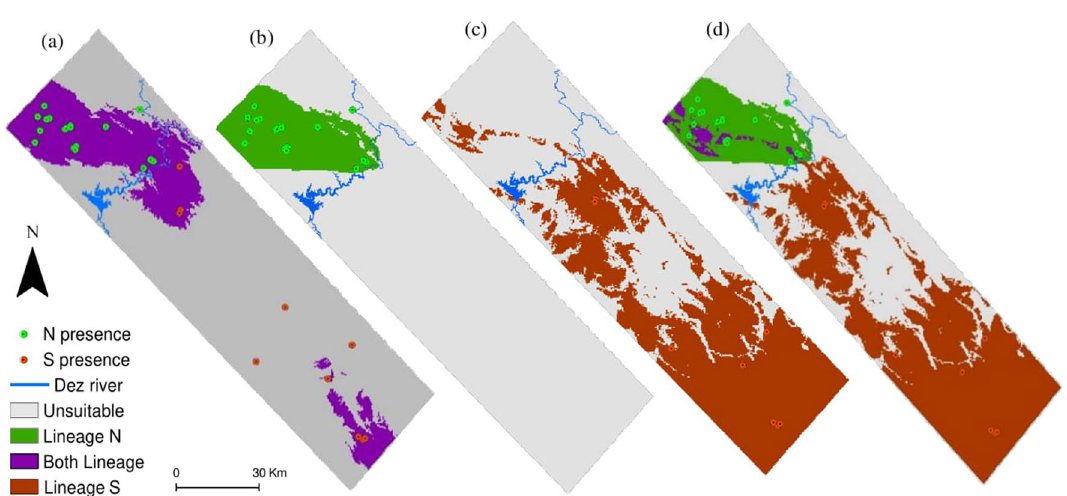
Figure 2. Potentially climatic suitable areas according to ( a ) Species-level binary model, ( b ) N lineage binary model, ( c ) S lineage binary model and ( d ) overlay of binary models of the two lineages (N + S binary model) for Neurergus kaiseri at the landscape scale. The Dez River is depicted as a reference for lineages